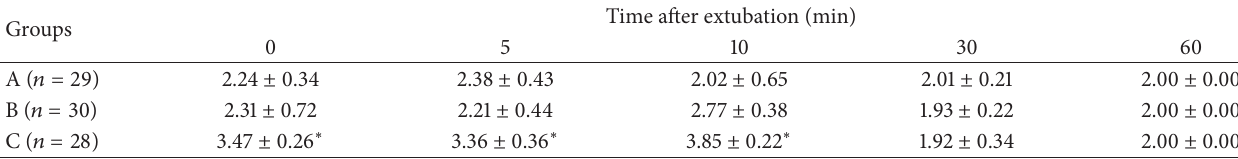
Table 3: Ramsay calm score among the three groups (mean ± SD).